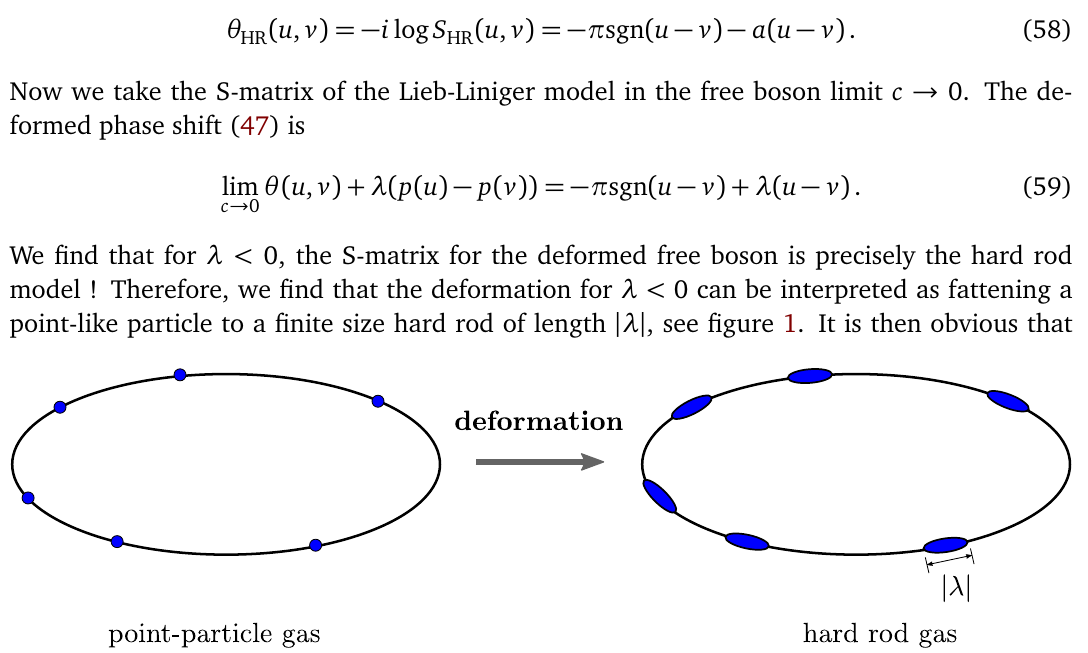
Figure 1: The simple bilinear deformation turns a free bose gas into a free hard rod